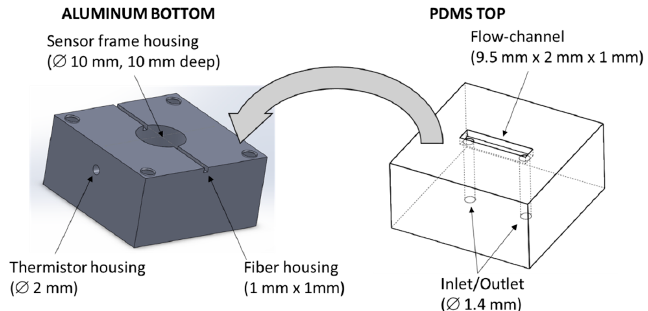
Figure 2. On the left: The flow cell aluminum bottom part with the sensor frame housing for the plastic optical fiber, and the thermistor housing. On the right: The PDMS top part, with the flow-channel (9.5 mm long, 2 mm wide, 1 mm deep) and the holes for the fluid inlet and outlet.